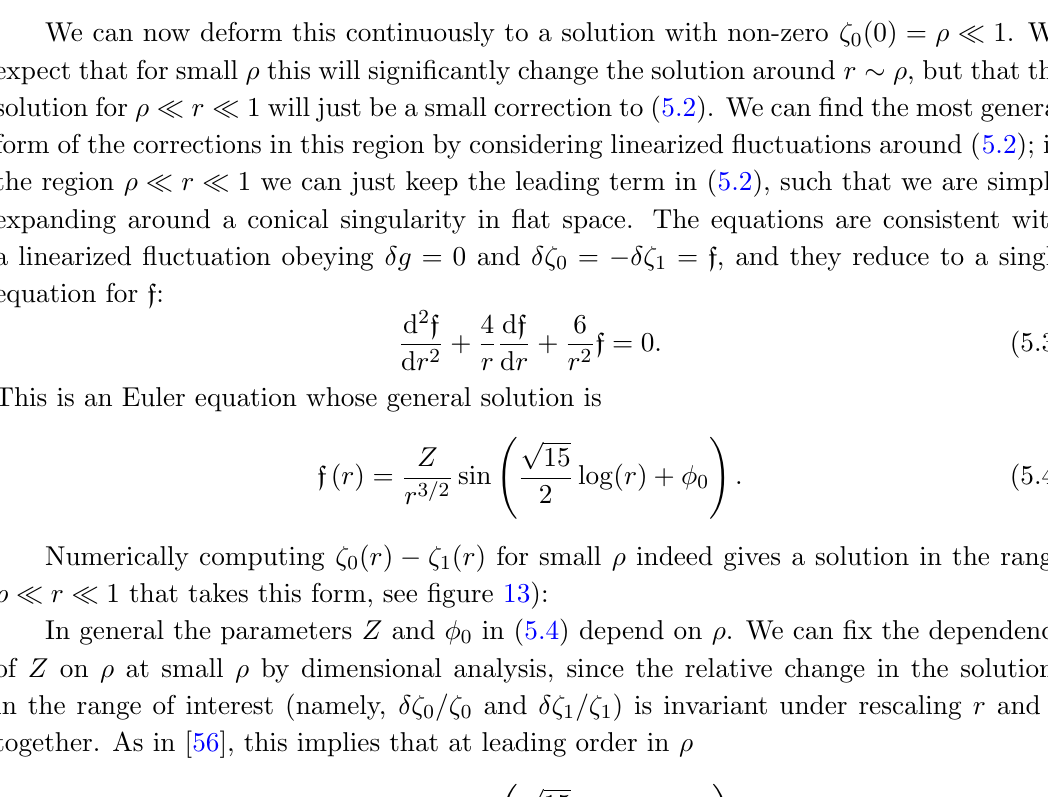
Figure 13 . The warp factor di(cid:11)erence (cid:12)t (cid:16) 1 (cid:0) (cid:16) 0 for M = S 3 (cid:2) S 3 with (cid:26) = 10 (cid:0) 6